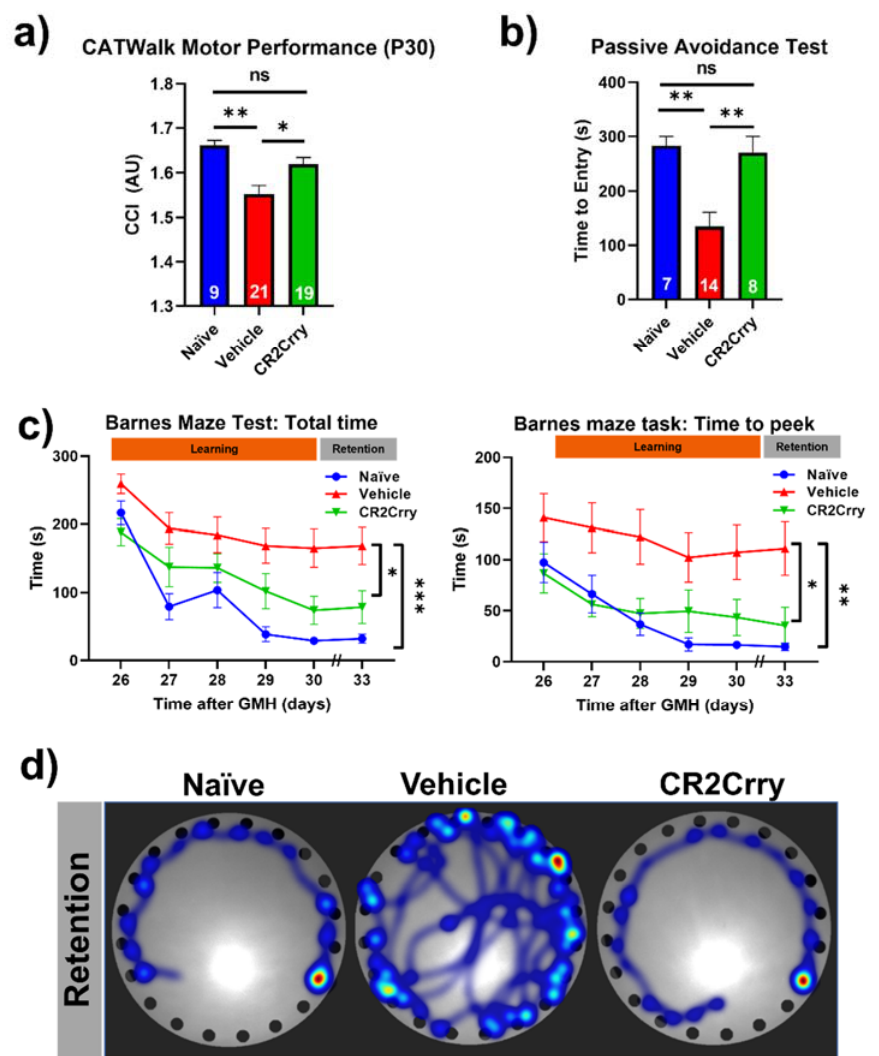
Figure 9. CR2Crry treatment improves motor performance and cognitive performance of GMH injured mice. ( a ) Gait analysis evaluated using Catwalk XT. The output variables for all four limbs were combined into a previously described Combined Catwalk Index (CCI) 26 days after injury (P30). One-way ANOVA with Bonferroni’s correction for multiple comparisons. * p < 0.05, ** p < 0.01. Error bars = mean ± SEM. ( b ) Passive avoidance test (time to entry) performed 36 days after injury (P40) shows improvement in fear-conditioned learning in CR2Crry animals and naïve as compared to vehicle. One-way ANOVA with Bonferroni’s correction for multiple comparisons. ** p < 0.01. Error bars = mean ± SEM. ( c ) Barnes maze task performed beginning at 26 days after injury (P30). There was a training period of 5 days followed by a two-day rest period and subsequently underwent testing to evaluate retention memory 33 days after injury (P37). Variables presented were total latency and latency to first peek into the escape hole. Two-way ANOVA with Bonferroni’s correction for multiple comparisons. * p < 0.05, ** p < 0.01, *** p < 0.001. n = 7 for naïve, n = 21 for vehicle, and n= 16 for CR2Crry. Error bars= mean ± SEM. ( d ) Representative heat maps of movement of mice from the three treatment groups on the platform on the retention day. No data points were excluded from the analysis.